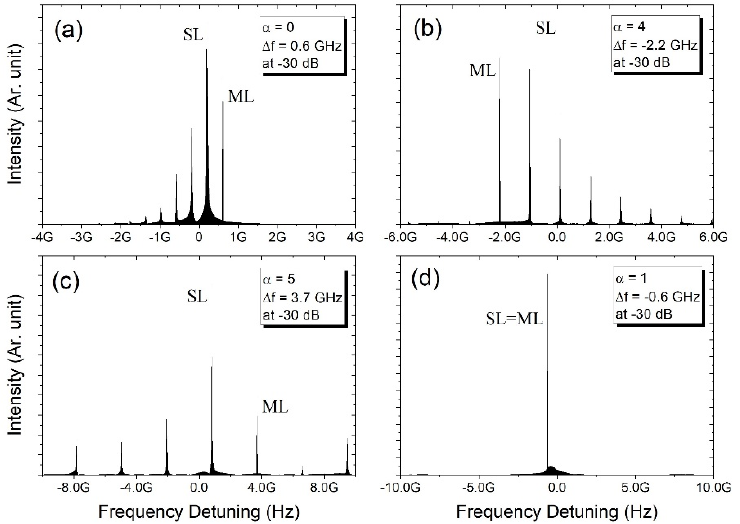
Figure 3. The power spectra of the laser output taken at the levels shown in Figure 2. ( a ) α = 0 and ∆ f = 0.6 GHz, ( b ) α = 4 and ∆ f = − 2.2 GHz, ( c ) α = 5 and ∆ f = 3.7 GHz and ( d ) α = 1 and ∆ f = − 0.6 GHz. Note that the injection level in all cases is constant ( − 30 dB).